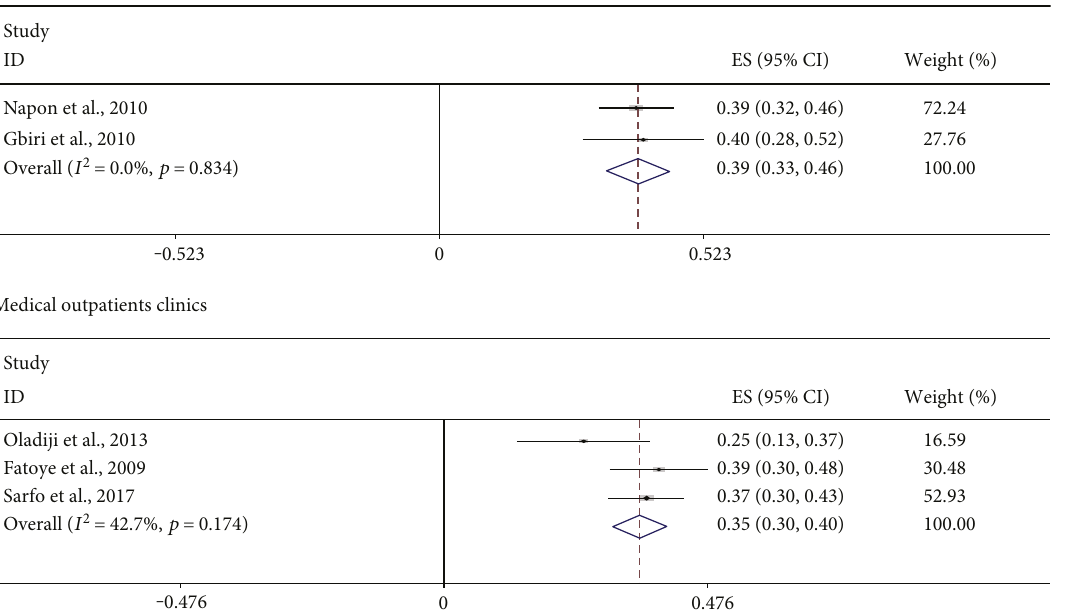
Figure 3: Forest plots showing the pooled prevalence of poststroke depression (using rating scales) in medical inpatient/outpatient